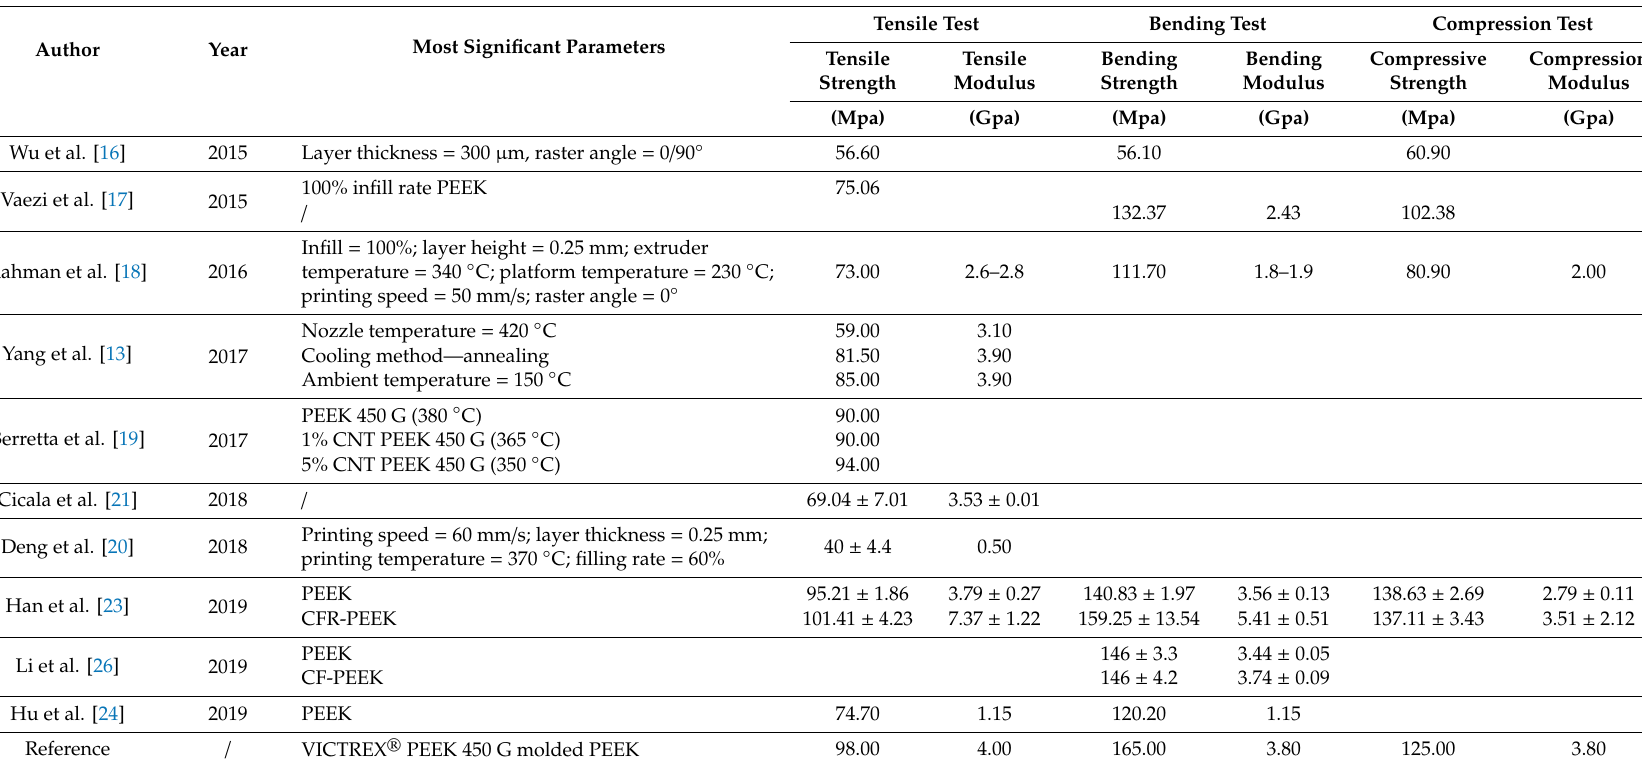
Table 2. Influence of PEEK processing parameters on mechanical